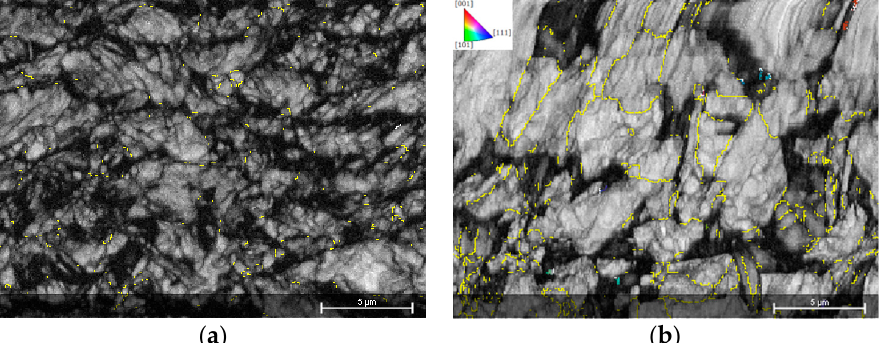
Figure 9. ( a ) EBSD PQM phase map of Steel A microstructure at the tensile test specimen crack tip where no austenite (fcc) was detected. ( b ) EBSD PQM map of Steel C IBT 450 microstructure at